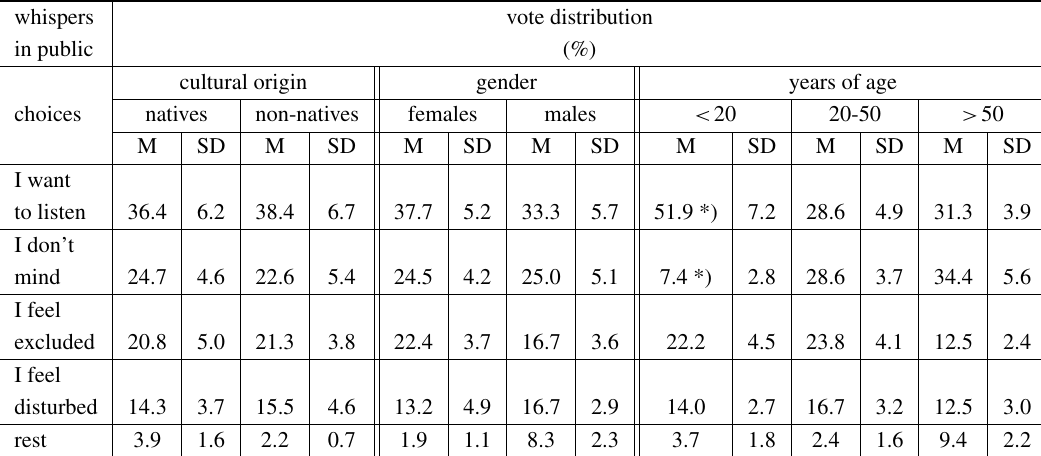
Distribution of votes collected during a general inquiry (sample size: 350 people). Data are given in per- centages (M=mean; SD=standard deviation). The sample includes 76% natives, i.e. Germans.